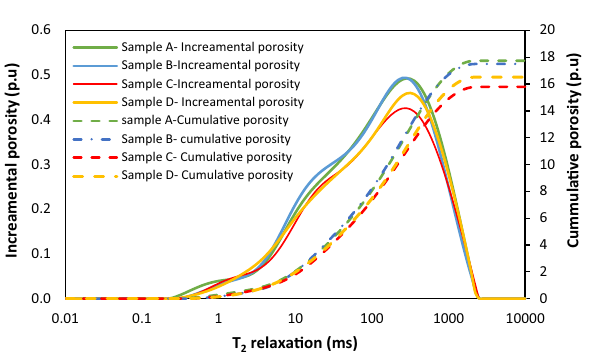
Fig. 1 NMR T 2 relaxation for all samples. Continuous lines show the probability distribution function (PDF) of the pores (pore size distri- bution of the samples), while the broken lines show the cumulative distribution function (CDF) of their porosity